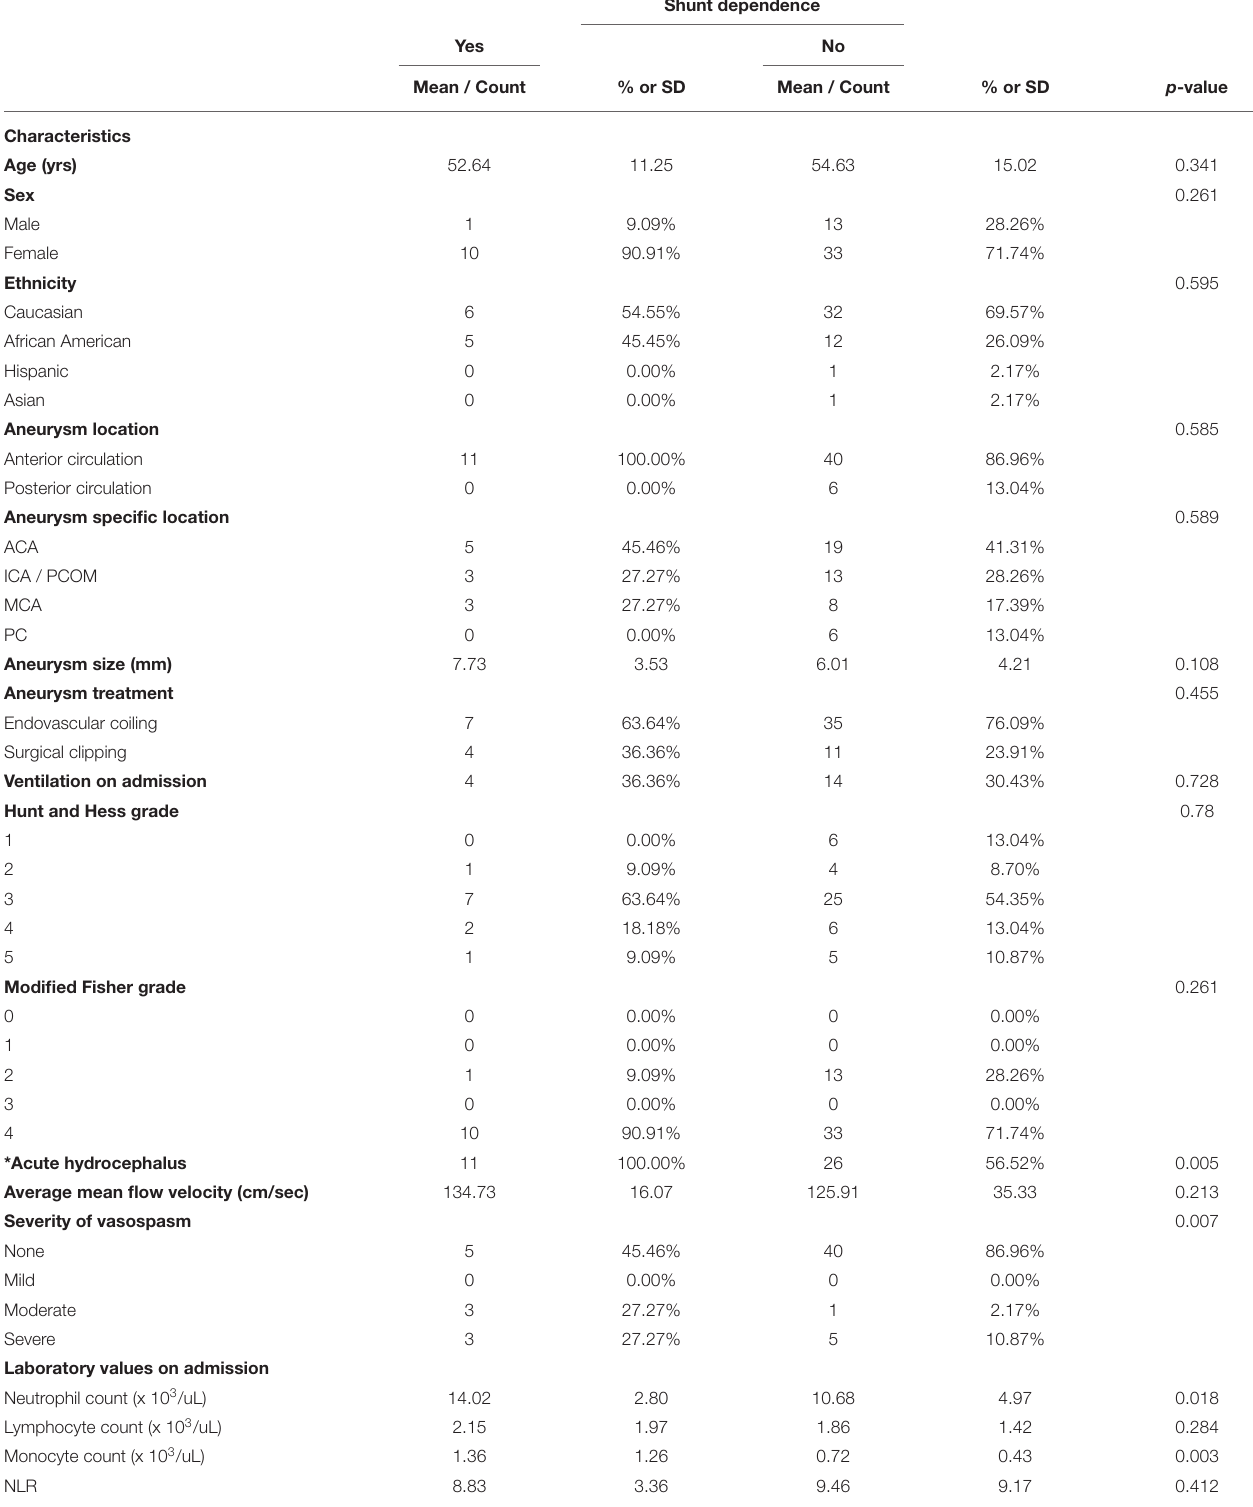
TABLE 6 | Sub-cohort univariate analysis of predictors of shunt dependence after aneurysmal subarachnoid hemorrhage in patients with intraventricular hemorrhage. Shunt